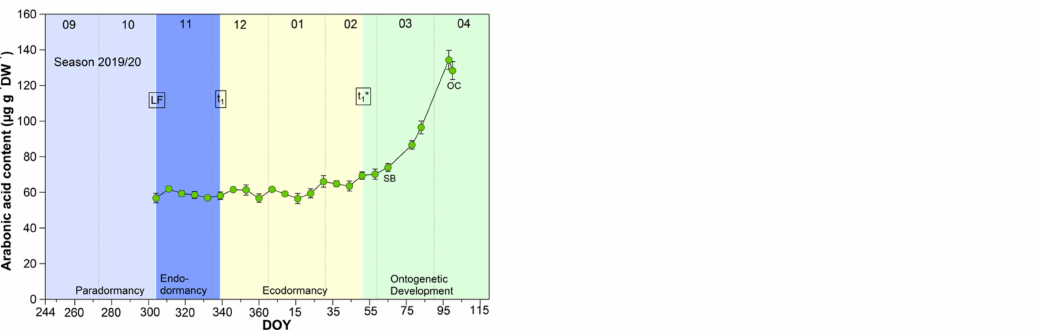
Figure 2. Arabonic acid in sweet cherry buds cv. Summit, 2011/12–2019/20. ‘Total leaf fall’ (LF), endodormancy release (t 1 ), beginning of ontogenetic development (t 1 *), ‘swollen bud’ (SB) and ‘open cluster’